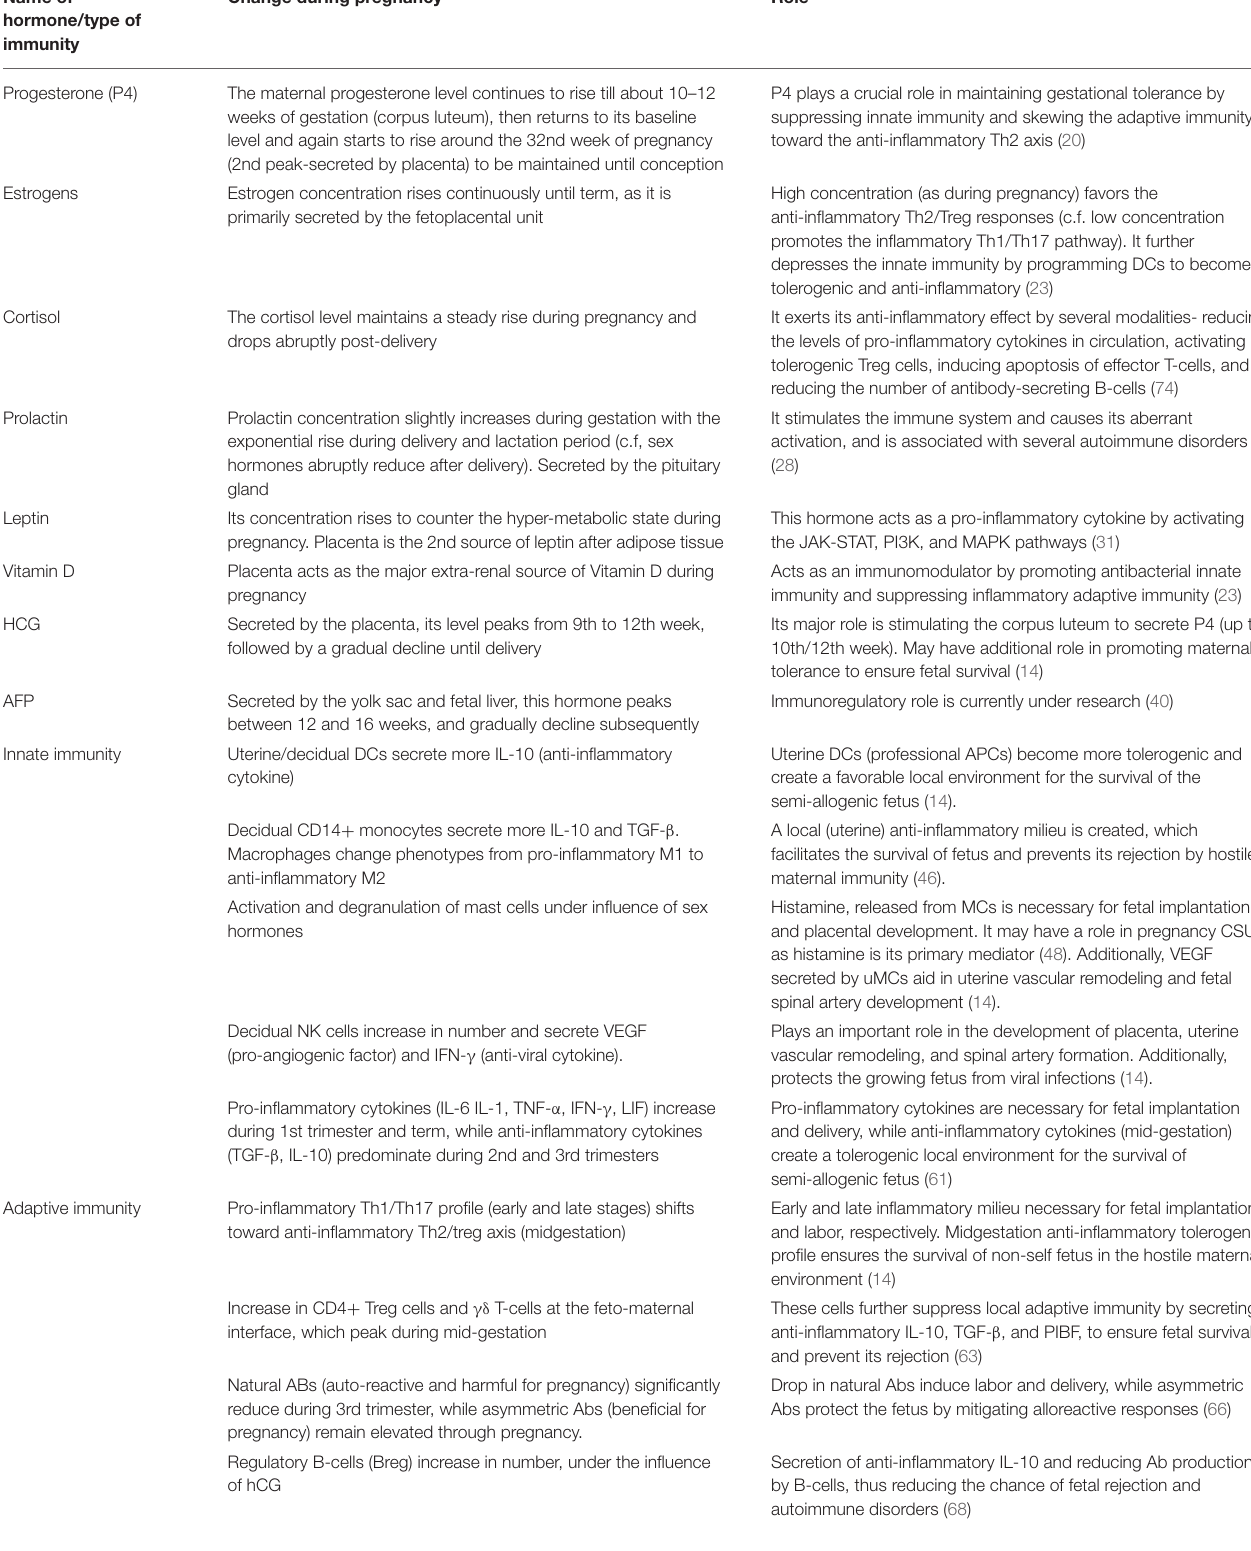
TABLE 1 | Hormonal and immunological changes during